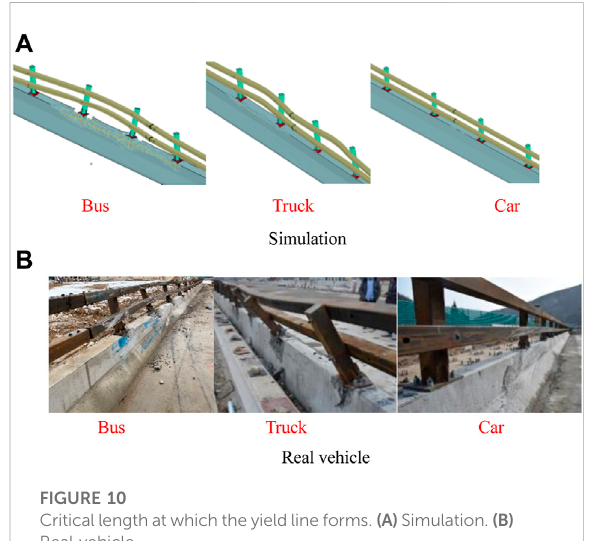
FIGURE 10 Criticallength atwhich theyieldlineforms. (A) Simulation. (B) Real vehicle.